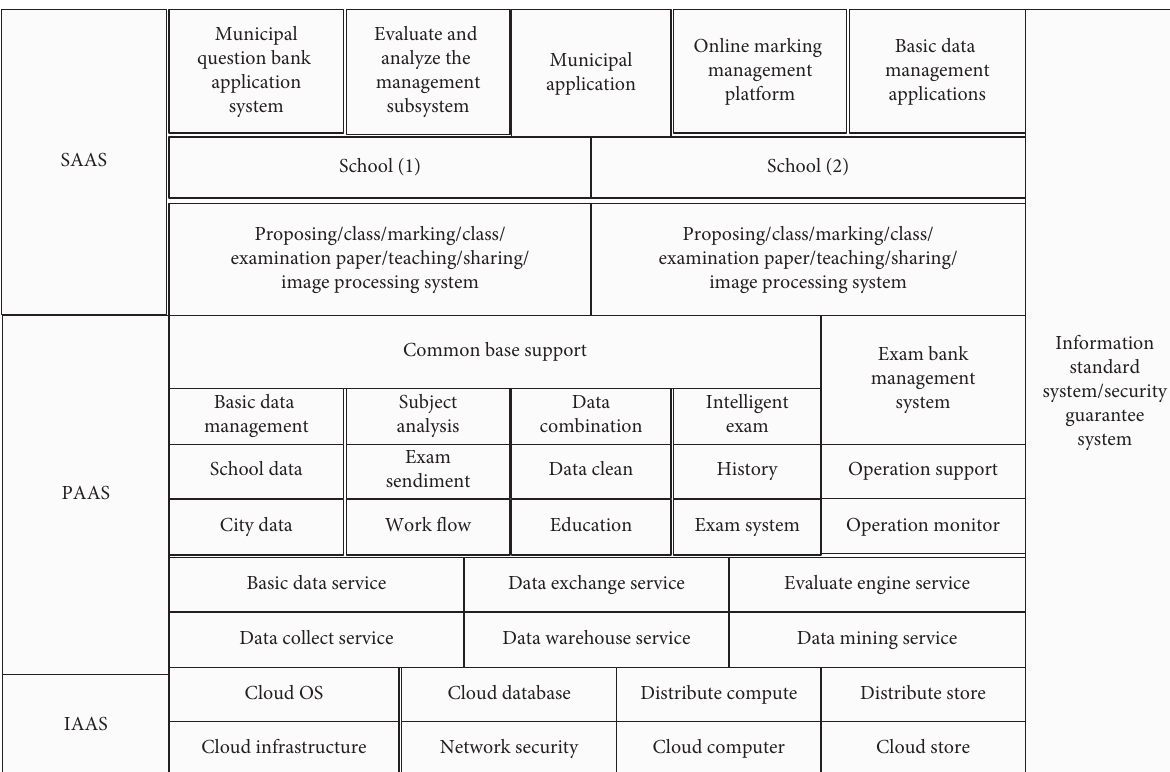
Figure 5: The functional architecture of the massive education big data cloud